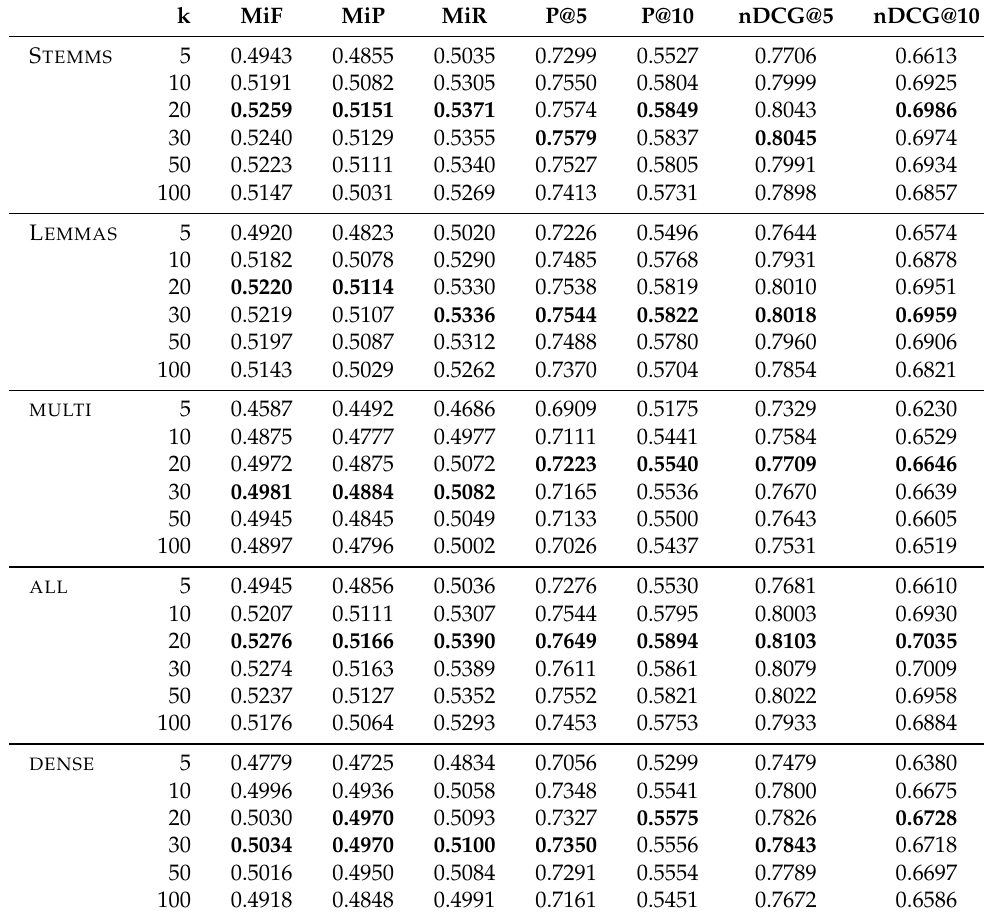
Table 3. Performance metrics with sparse vs. dense